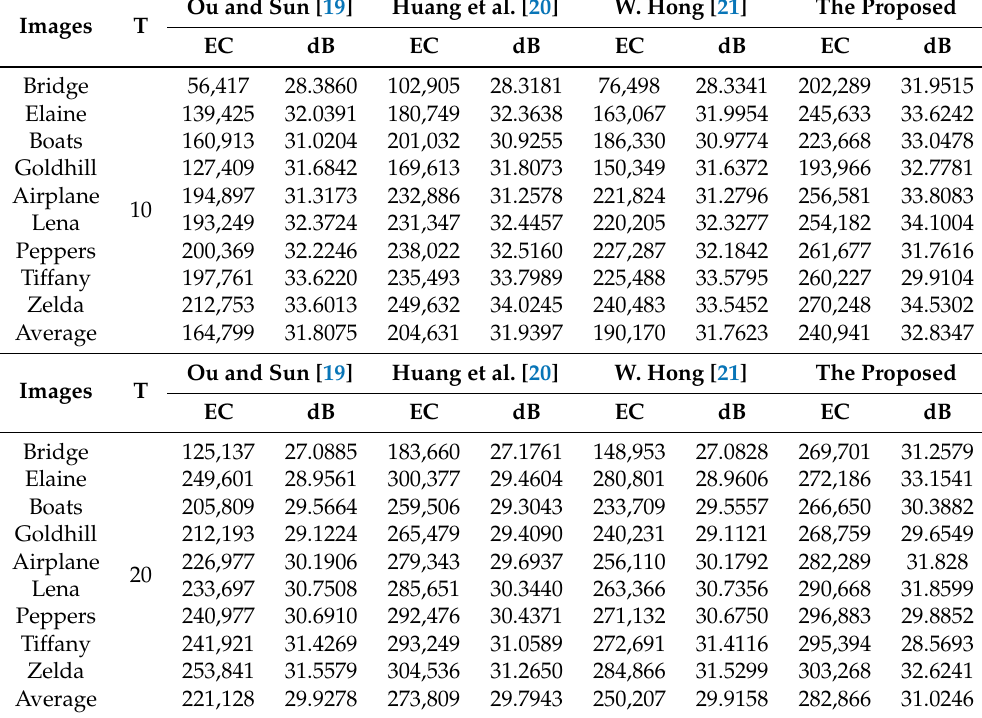
Table 4. Comparison of the performance using EC and PSNR of the proposed method and existing methods (where our proposed scheme is based on Adaptive BTC based on Edge Quantization (ABTC-EQ) and the others are based on